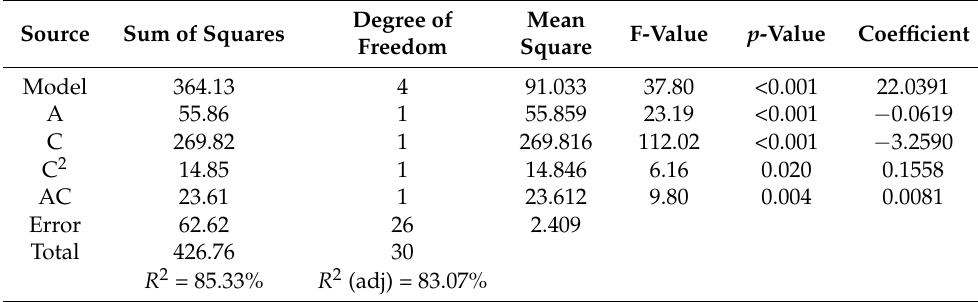
Table 3. The ANOVA of the reduced regression model for material removal rate (MRR) of EDM with side